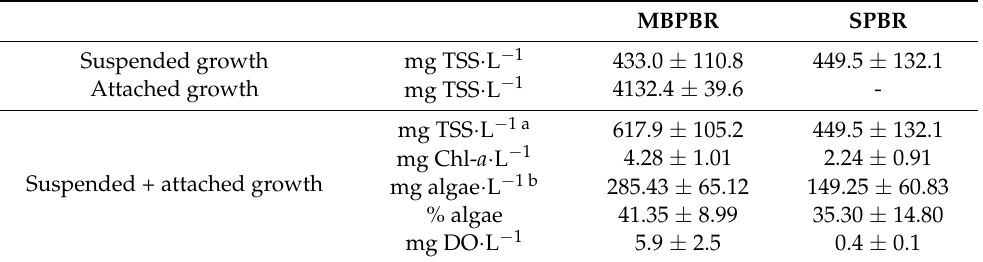
Table 1. Biomass concentrations and photosynthetic oxygen production of the photobioreactor (PBR) with a moving bed (MBPBR) and PBR without a moving bed